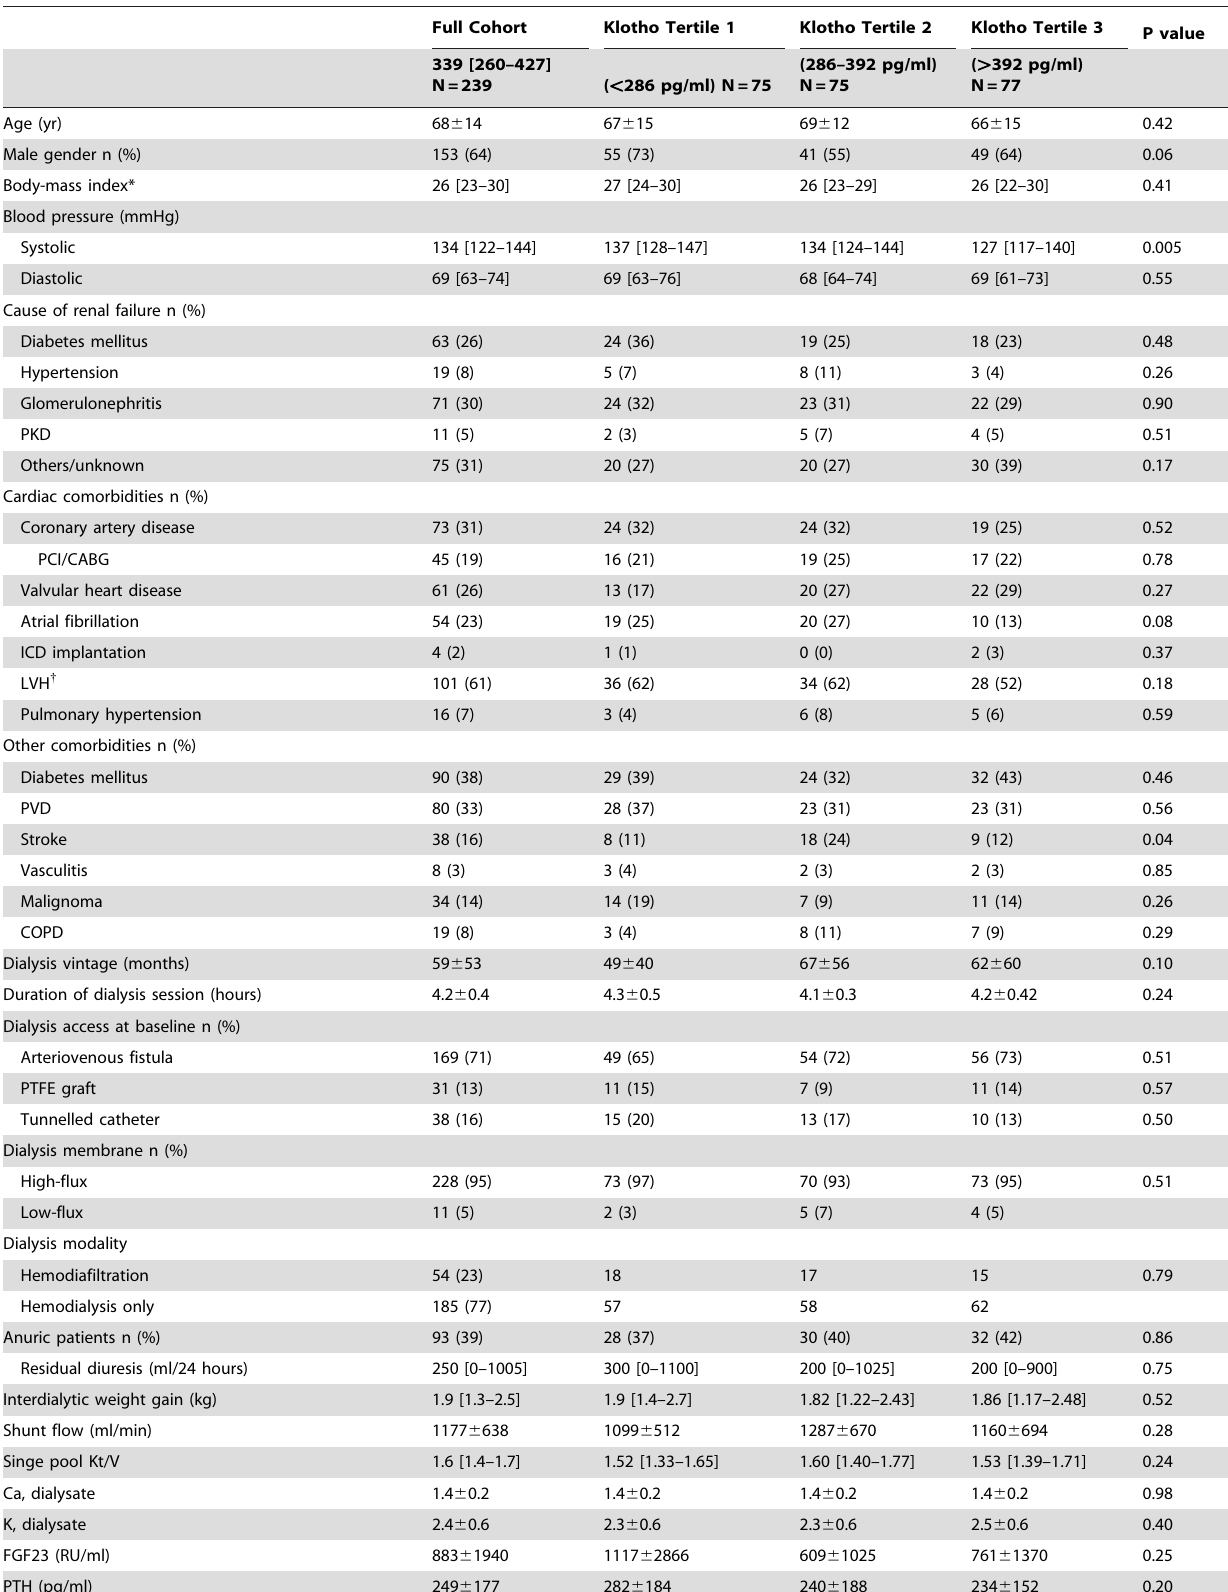
Table 1. Baseline characteristics and laboratory parameters according to Klotho